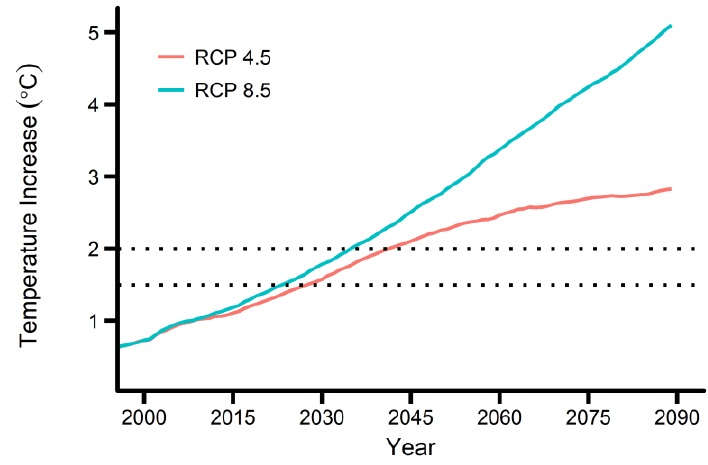
Figure 1. 20-year average maximum temperature increases above the pre-industrial baseline for seven major cities of South Korea. RCP, Representative Concentration Pathway.